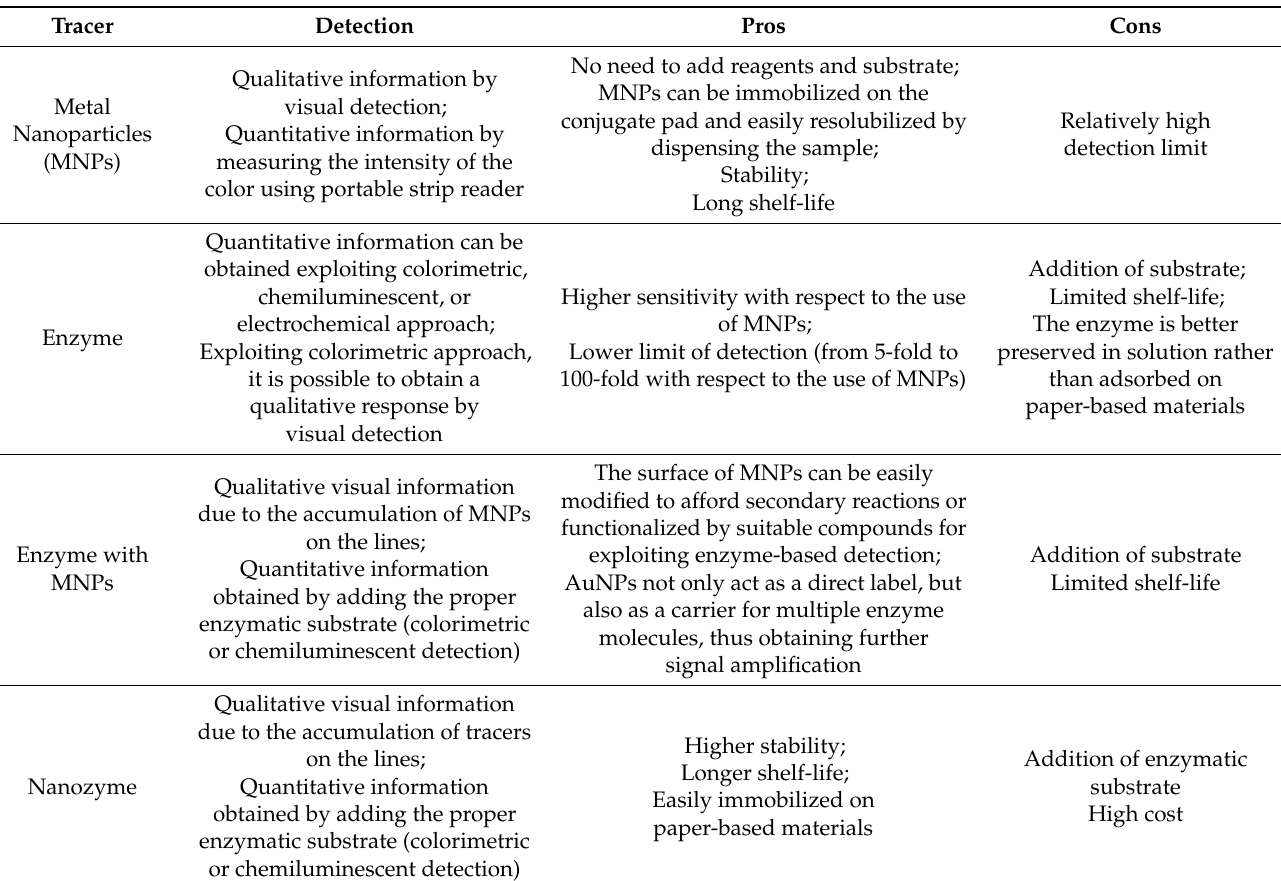
Table 3. Scheme of the enzymatic-based tracers used in LFIA compared with the traditional MNPs labels.